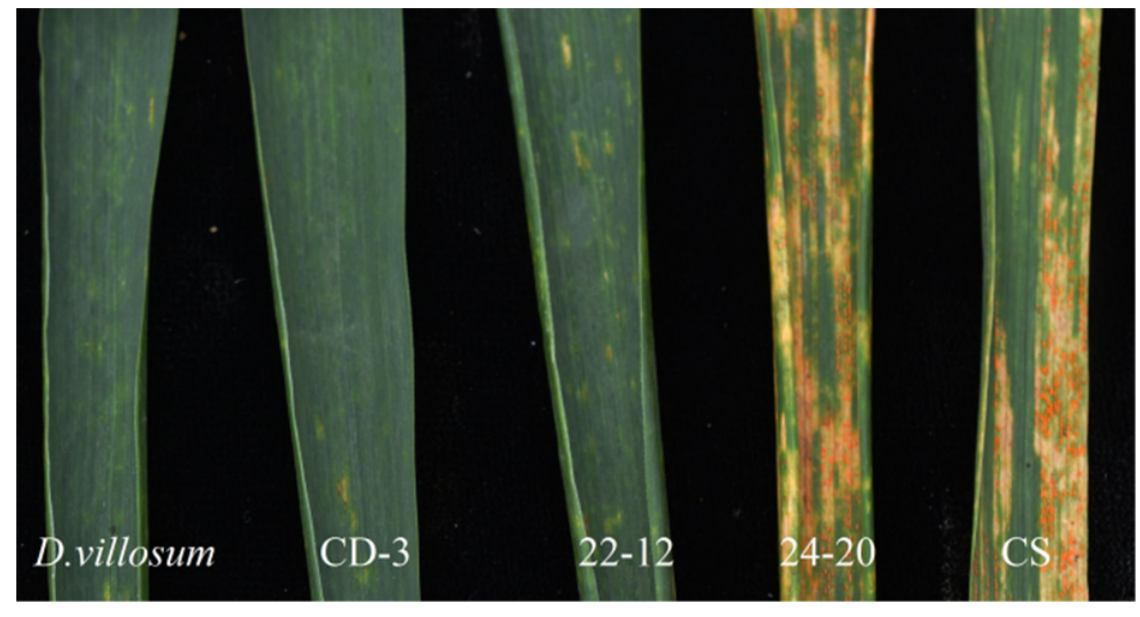
Figure 3. Phenotypic response to stripe rust of D. villosum , CD-3, 22-12, 24-20 and CS.